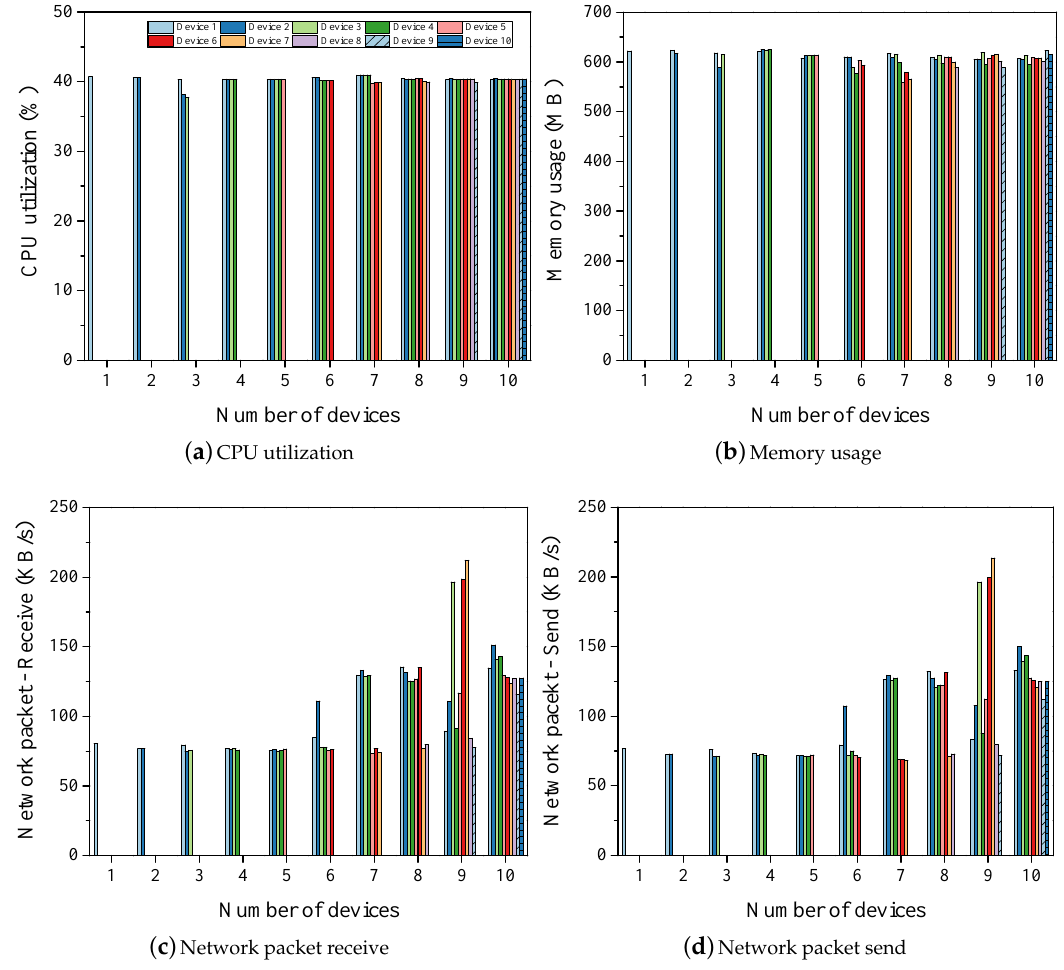
Figure 7. Hardware resources for training ResNet 110 ×